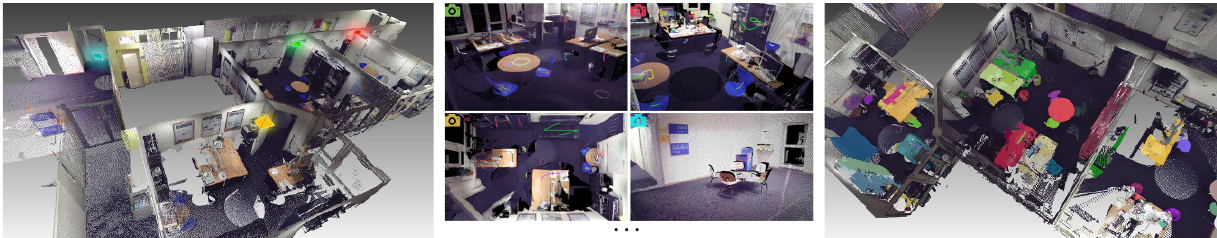
... Fig. 1 Given an input scene represented as a 3D point cloud (left), our system automatically suggests a series of reasonable views (middle) for easily inputting segmentation hints for semantic segmentation of the entire scene